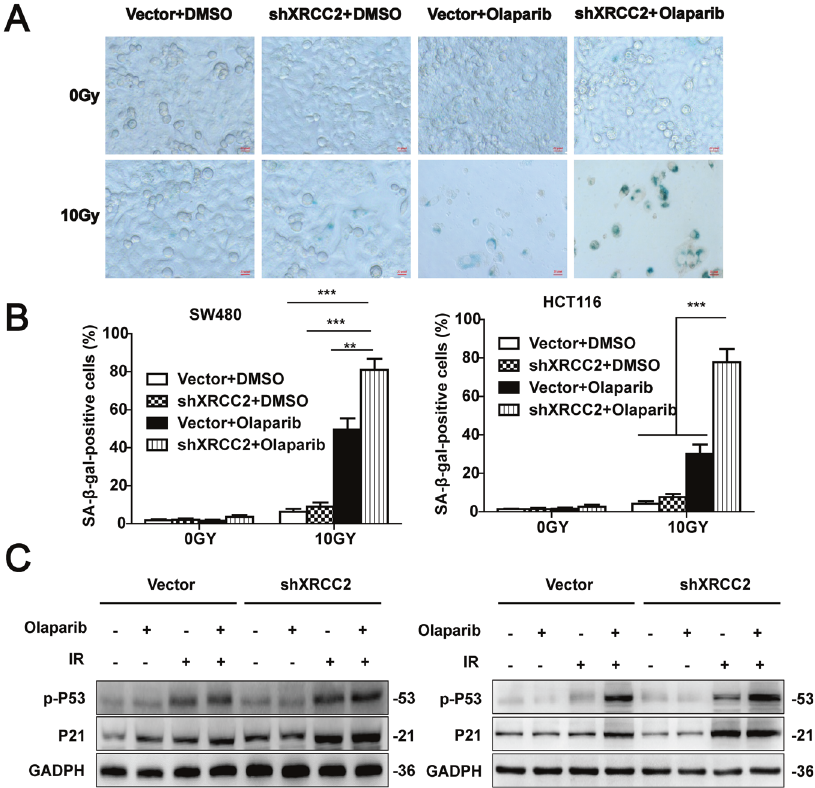
Fig. 5 Effect of olaparib on senescence after in vitro IR treatment. A Representative images of senescence ( β -gal activity) after 48 h in the different treatment groups (×40). B Quanti fi cation of microscopy results. Results show means ± SDs from three independent experiments. ** P < 0.01, *** P < 0.001. C Representative western blotting of phospo-P53 and P21 in SW480 cells (left) and HCT116 cells (right) in the different treatment